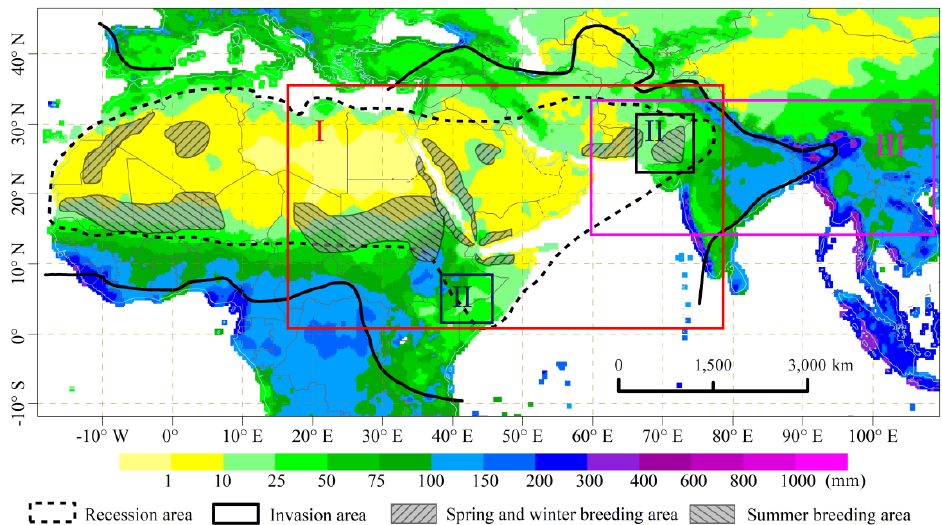
Figure 1. The spatial distribution of the annual rainfall in the breeding area, recession area and invasion area of the African desert locust.